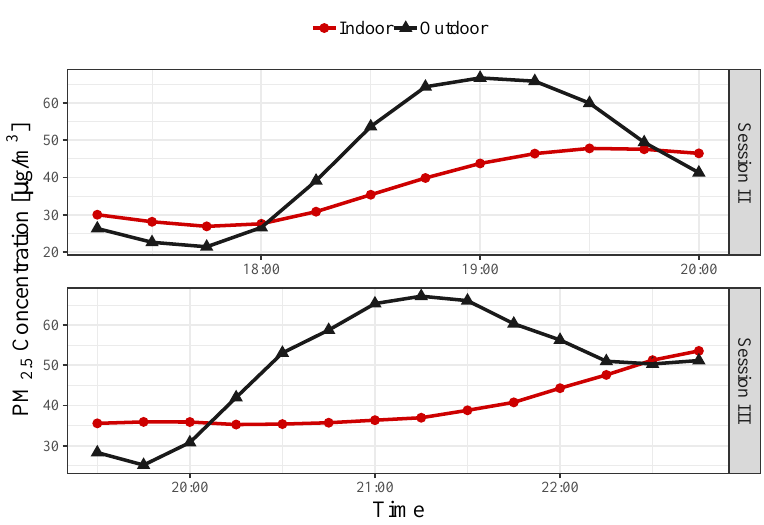
Figure 6. Indoor and outdoor PM 2.5 mass concentration time